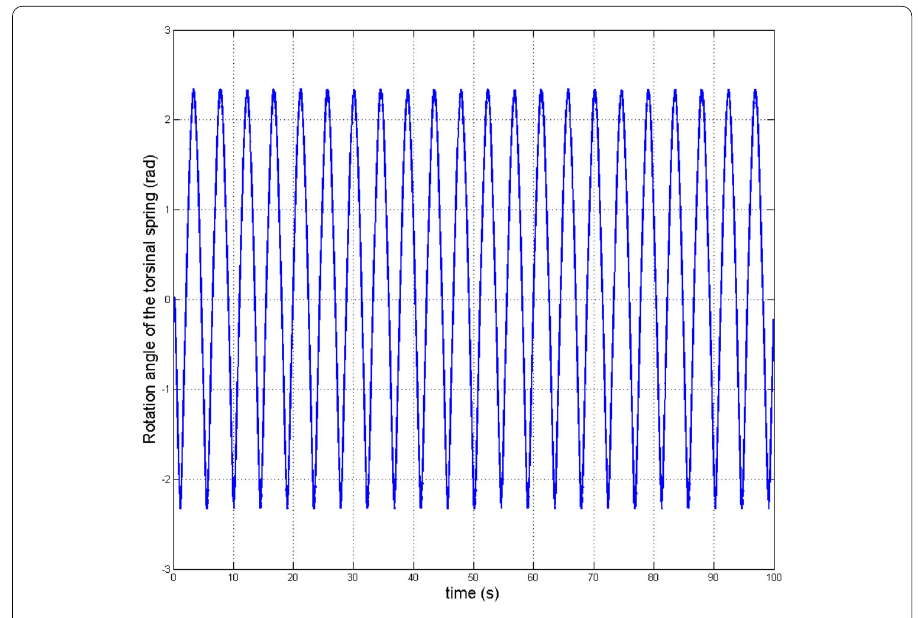
Fig. 26 Spring rotation angle history